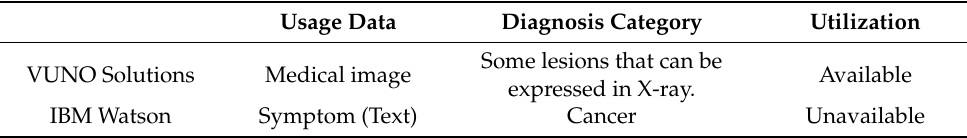
Table 1. A diagnostic solution using deep learning used in